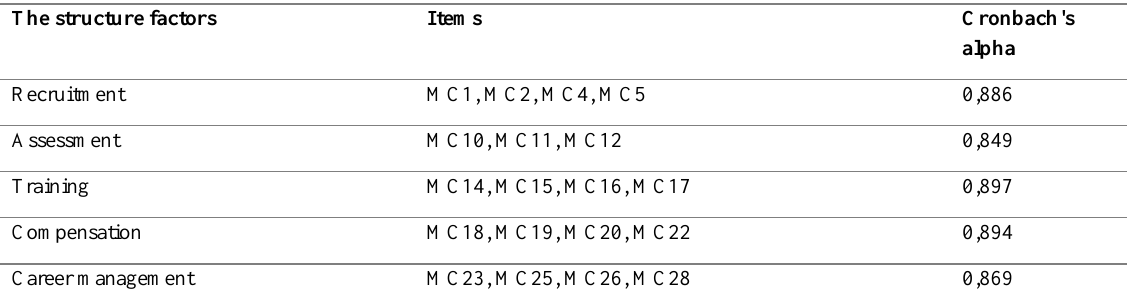
Table 4 : The results of reliability